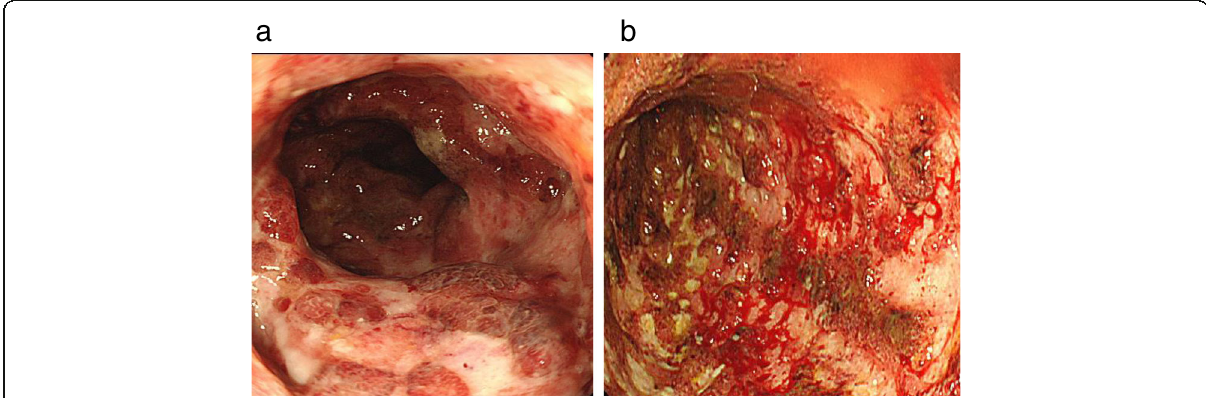
Fig. 3 Colonoscopy images. a Colonoscopy revealing extensive ulceration of the mucosa. The surface is irregular and erythematous with loss of the normal vascular markings. b Extensive pseudopolyps in the